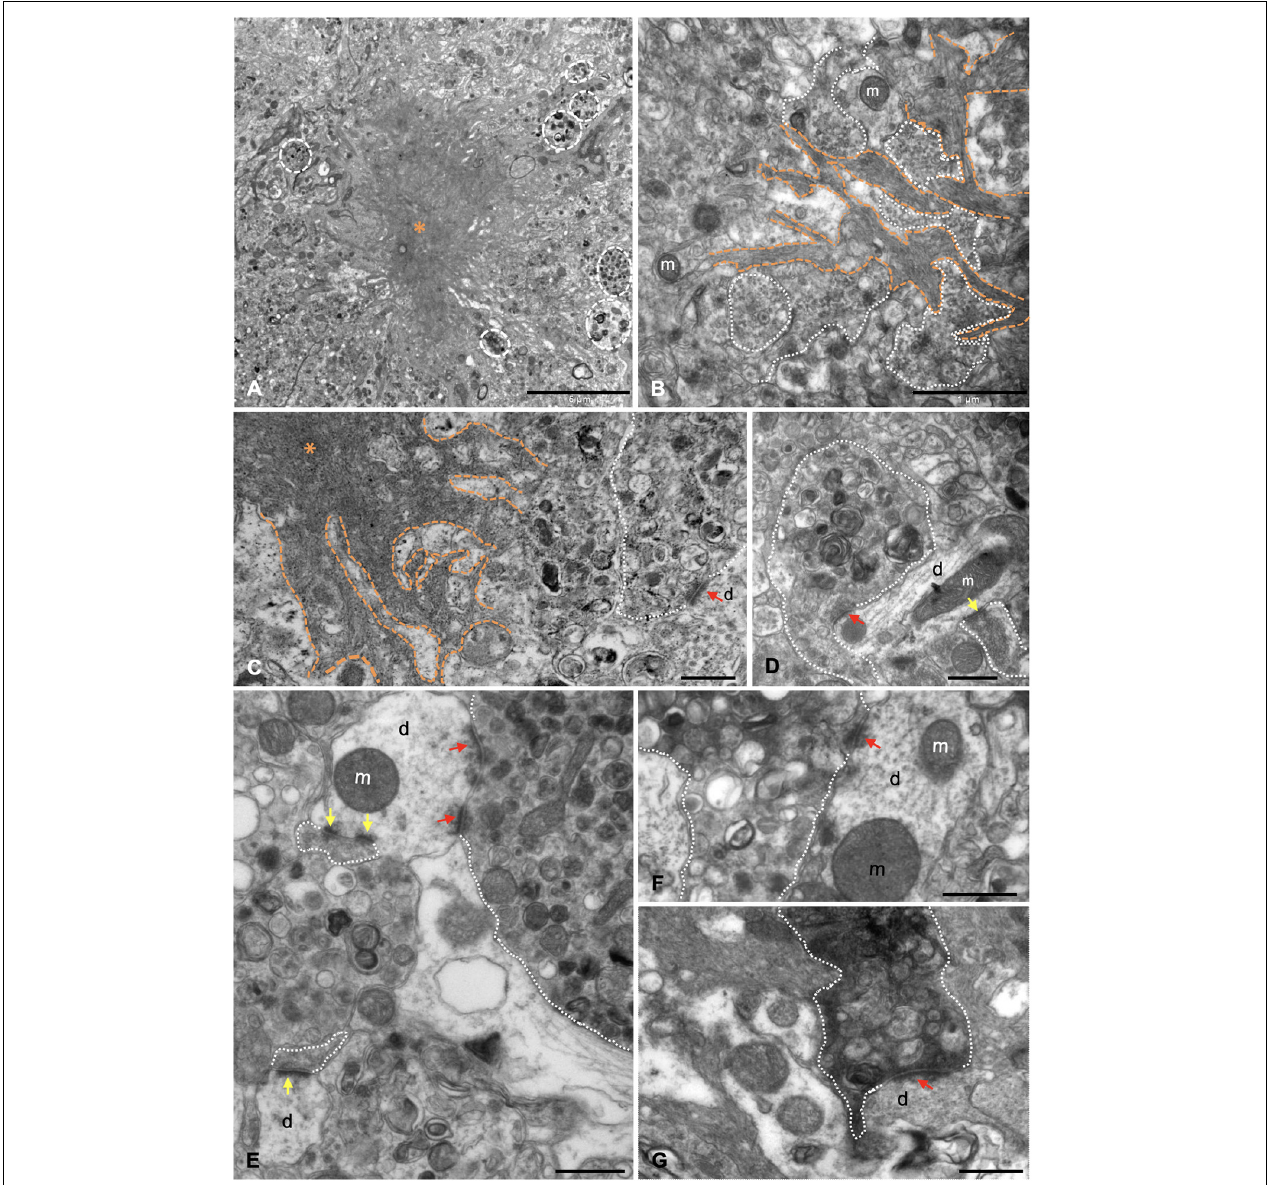
FIGURE 3 | Dystrophic presynaptic boutons, filled with autophagic vesicles, are associated with extracellular A β deposits. (A) Panoramic view of a neuritic plaque (asterisk) by transmission electron microscopy (TEM), surrounded by dystrophic neurites (discontinuous white circles) in 4.5-month-old APP/PS1. (B) A β branches (orange discontinuous lines) were found to be intermingled with aberrant neuronal processes (white dotted line); some of them were exhibiting accumulation of small like-synaptic vesicles. (C–F) TEM examination demonstrated there were null or very few synaptic contacts around the plaques. In some cases, synapses were established between apparently normal postsynaptic elements and abnormally enlarged presynaptic terminals (red arrows point to postsynaptic densities), filled with vesicles of autophagic nature, and, on the contrary, very few (if any) synaptic vesicles close the presynaptic densities. (G) Degenerating synapse (white dotted line) exhibiting an electron dense presynaptic element still keeping contact with a dendritic spine (red arrow). m, mitochondria, d, dendrite/dendritic spine. Yellow arrows point to postsynaptic densities of apparently normal synaptic contacts. Scale bars, (A) 5 µ m; (B) 1 µ m; (C–G) 0.5 µ